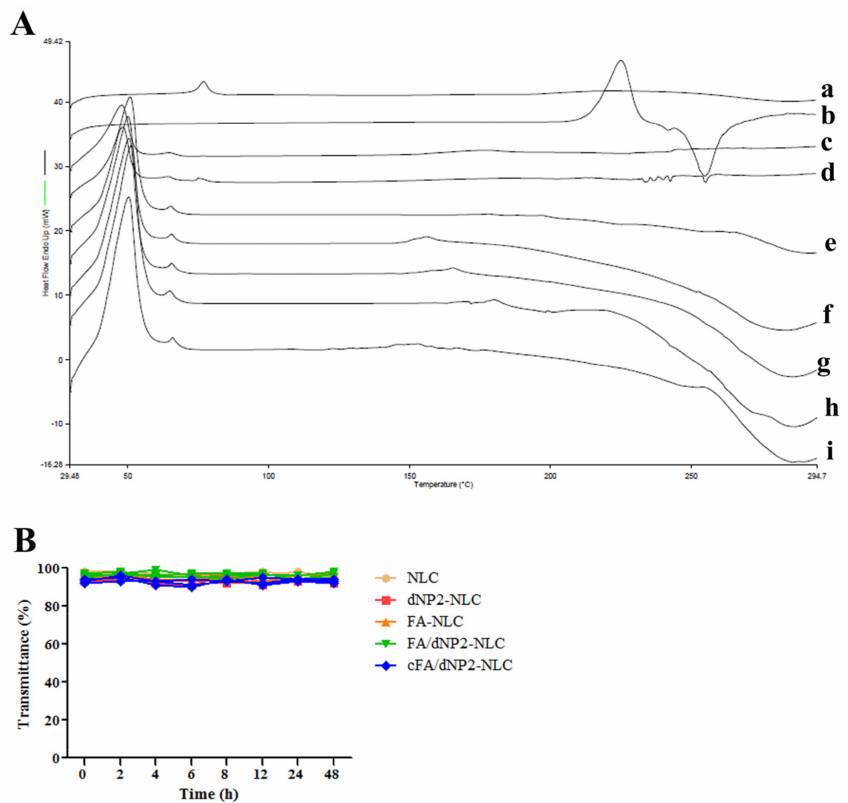
Figure 2. ( A ) Differential scanning calorimetry (DSC) of different formulations (a: GA, b: PTX, c: Blank-NLC, d: the physical mixture of NLC’s formulation and GA + PTX, e: GA/PTX-NLC, f: dNP2- GA/PTX-NLC, g: FA-GA/PTX-NLC, h: FA/dNP2-GA/PTX-NLC, i: cFA/dNP2-GA/PTX-NLC). ( B ) The variations of transmittance of NLCs in 50% Fetal Bovine Serum (FBS) over 48 h (mean ± SD, n = 3).